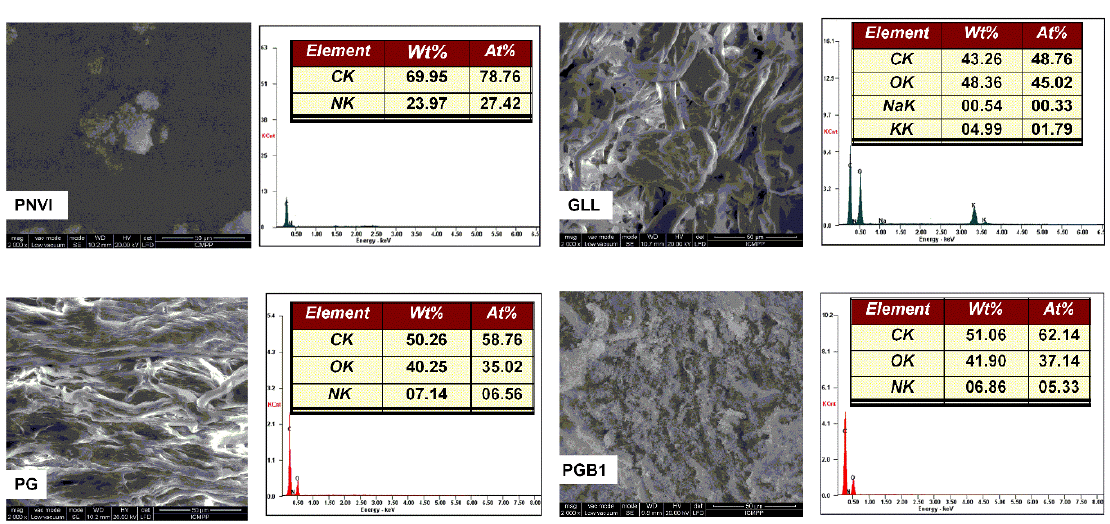
Figure 11. Scanning electron microscope (SEM) images and energy dispersive X-ray (EDAX) analysis of PNVI, GLL, PG and PGB1 samples. of PNVI, GLL, PG and PGB1